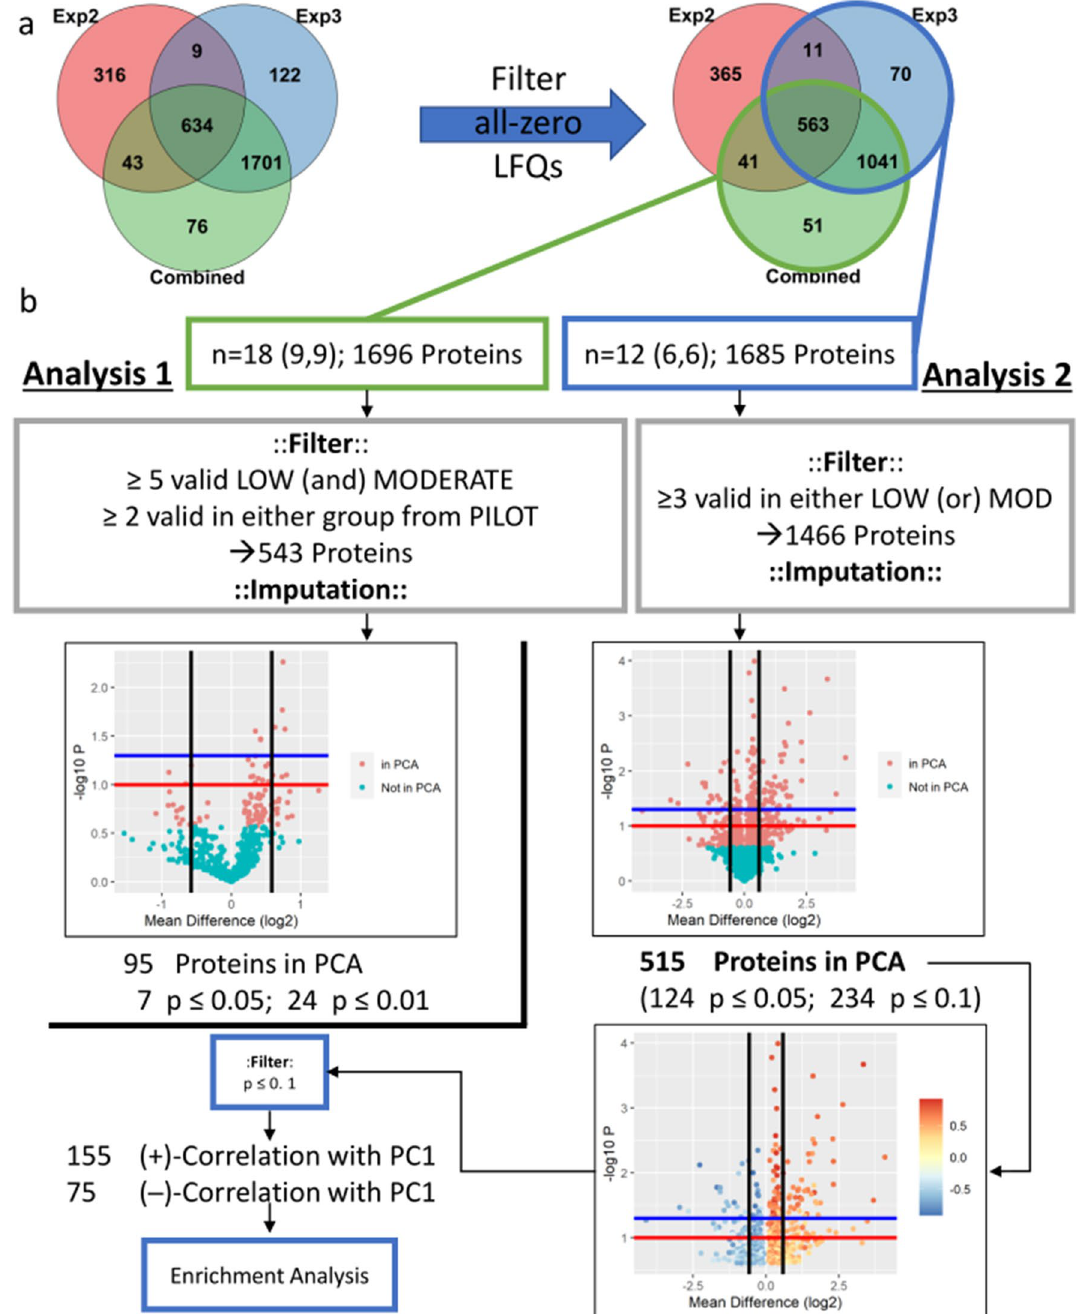
Figure 2. Workflow for proteomics data analysis. ( a ) Number of proteins identified by unique FASTA identifier. Proteins with LFQ = 0 for all related samples were filtered out before downstream analysis. ( b ) Analysis 1 (green outline) included proteins with LC–MS/MS data from Experiment 2 (Pilot) and Experiment 3 (Comprehensive) combined and was more conservatively filtered due to the overrepresentation of proteins with no valid values in the Experiment 2 subset. Analysis 2 (blue outline) used only proteins identified from Experiment 3. Missing values (LFQ = 0) were imputed from a downshifted normal distribution and protein expression between humidity groups was analyzed by Welch’s t-Test. Distribution of the log10(p) and group mean difference (log2 scale) are shown below: black vertical lines represent a mean difference of 0.58 (1.5-fold-change), the red and blue horizontal lines represent p = 0.1 and p = 0.05, respectively. This data was arranged by ascending p-value and assessed by principal component analysis. Separation between humidity groups was observed for the top 95 and 515 proteins for Analysis 1 and Analysis 2, respectively, and these points are indicated on the graphs. Analysis 1 concluded due to the low number of significantly differentially expressed proteins identified. Analysis 2 separated the 515 proteins into those positively (red) and negatively (blue) correlated with the first principal component, and these lists were filtered by p < 0.1. These lists were mapped to available gene names by the UniProt Retrieve ID/Mapping tool and supplied to Metascape for gene enrichment